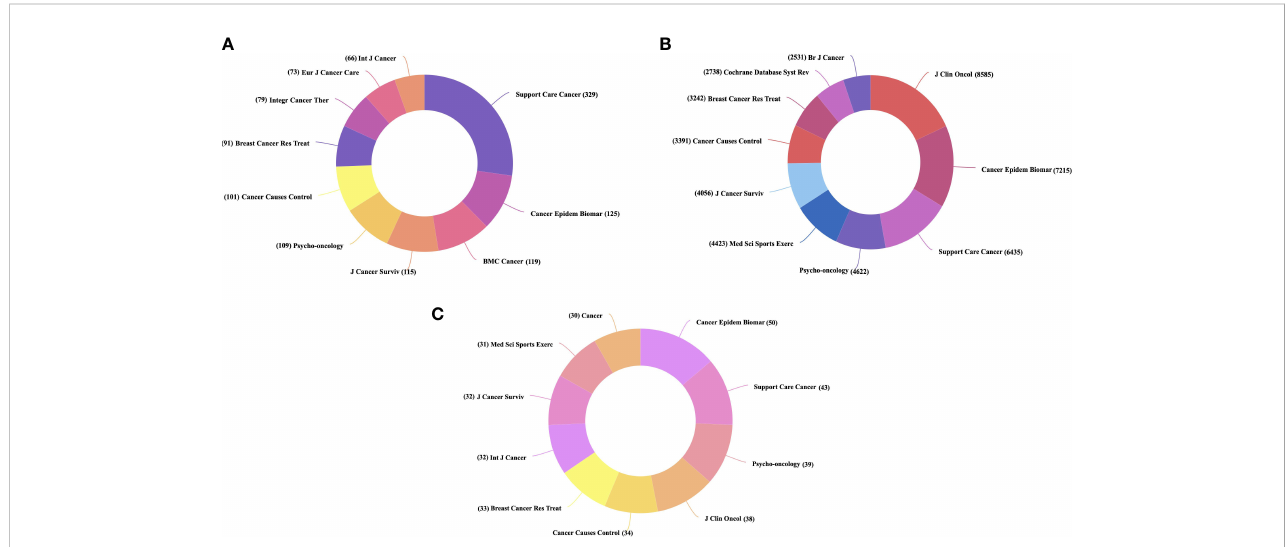
FIGURE 4 Distribution of Journals associated with SB, PA, and cancer. (A) Top 10 journals with the highest number of publications (B) Top 10 journals with the highest number of citations (C) Top 10 journals with the highest H-index.